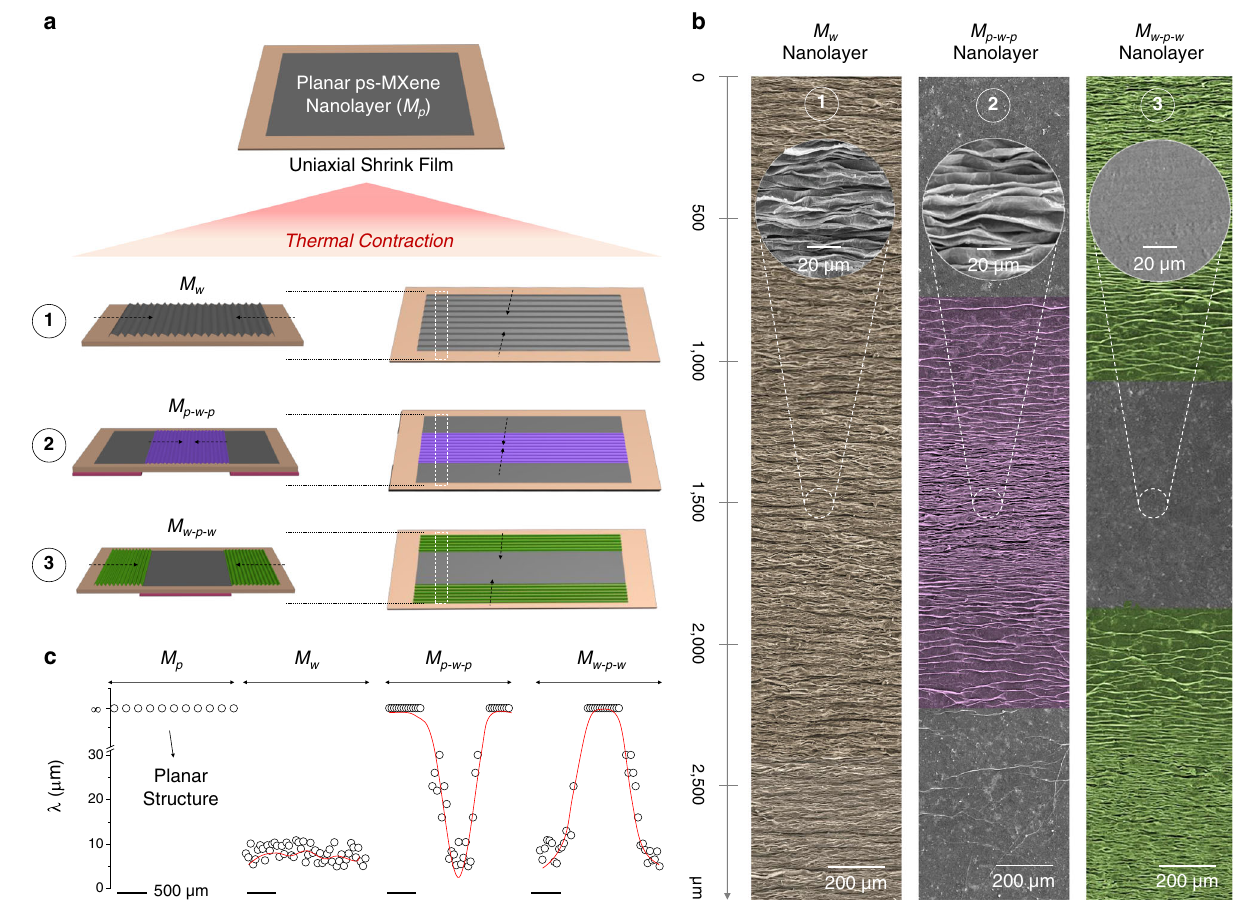
Fig. 1 | Controllable fabrication of wrinkle-like MXene textures via localized thermal contraction. a Fabrication of M w , M p-w-p , and M w-p-w nanolayers with localized periodic wrinkles. The red color regions refer to the areas fi xed with thin